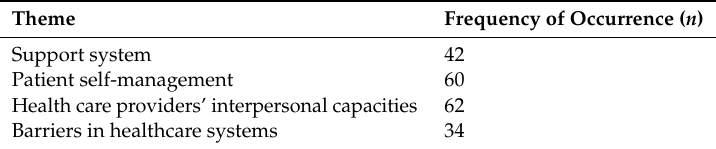
Table 2. Frequency of theme occurrence ( n = 103 articles).